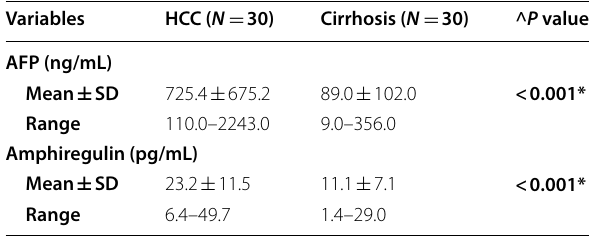
Table 4 Correlations of AFP and amphiregulin with other